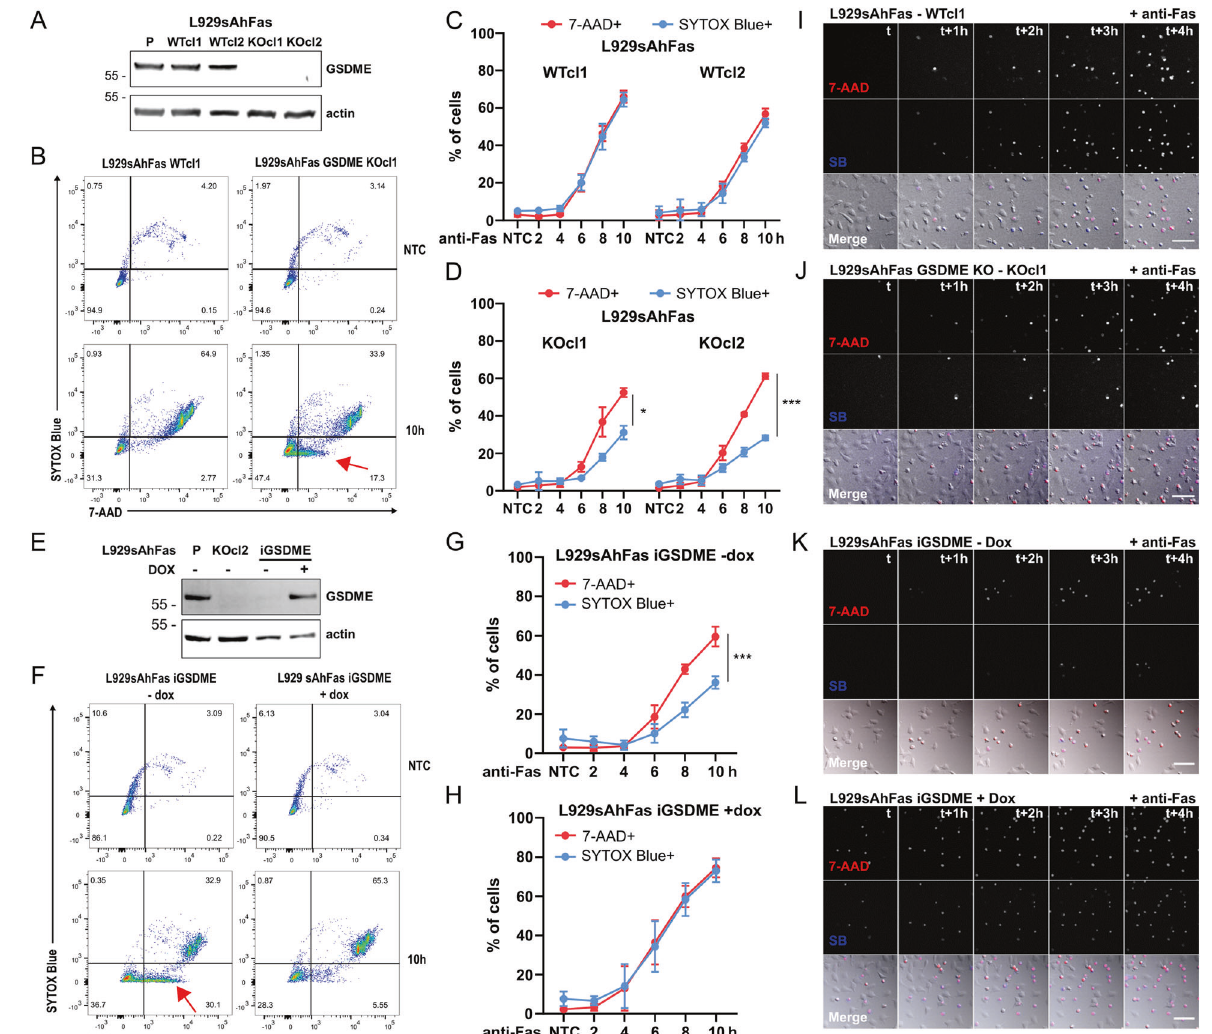
Fig. 1 Manipulation of GSDME affects 7-AAD and SB cell death marker dyes pattern in L929sAhFas during apoptosis-driven secondary necrosis. A Western Blot showing GSDME protein expression in L929sAhFas clones modi fi ed with CRISPR-Cas9 gene editing. B – D Flow cytometry analysis of the uptake of SB and 7-AAD in L929sAhFas WT and GSDME KO clones upon anti-Fas treatment. Results are presented as means ± SD ( N = 3). B Representative fl ow cytometric plots with red arrows pointing to 7-AAD single positive cells. C Levels of 7-AAD (red) and SB (blue) positive cells given as percentage of total cell population upon anti-Fas treatment for two L929sAhFas GSDME WT clones. D Percentage of 7-AAD and SB positive cells given as percentage of total cell population upon anti-Fas treatment for two GSDME KO clones. E Western Blot showing doxycycline-dependent expression of GSDME in L929sAhFas iGSDME cells compared to GSDME expression in the L929sAhFas parental (P) cells and in L929sAhFas GSDME KOcl2. F – H Flow cytometry analysis of the SB and 7-AAD staining in L929sAhFas iGSDME with or without doxycycline pretreatment upon apoptosis induction by anti-Fas. Results are presented as means ± SD ( N = 5). F Representative fl ow cytometry plots. G Percentage of 7-AAD and SB positive L929sAhFas iGSDME cells without doxycycline pretreatment upon anti-Fas treatment. H Effect of GSDME expression due to treatment with doxycycline on the amount of 7-AAD and and SB positive L929sAhFas iGSDME cells upon anti-Fas treatment. I – L Confocal images of L929sAhFas WT, GSDME KO cl1, iGSDME ( − Dox) and iGSDME ( + Dox) cells upon anti-Fas treatment showing uptake of 7-AAD and SB over time. h hours, dox doxycycline, 7-AAD 7-aminoactinomycin D, SB SYTOX blue; scale bar = 100 µM. Videos available in supplementary